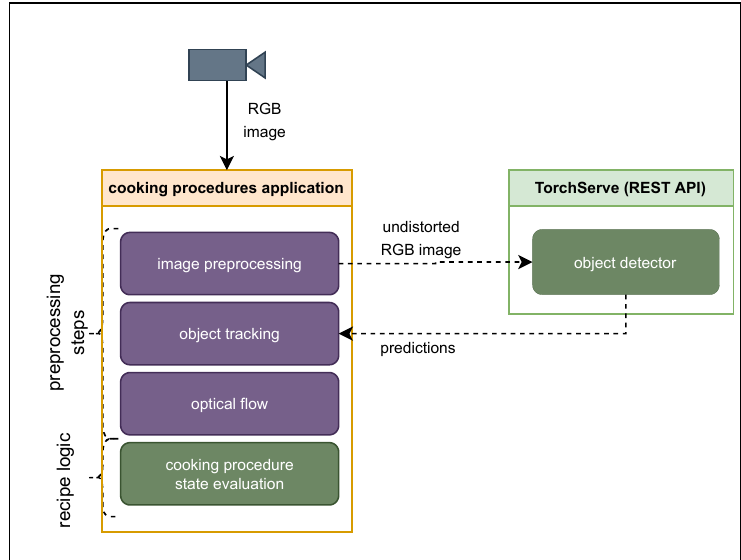
Figure 1. Application architecture of our